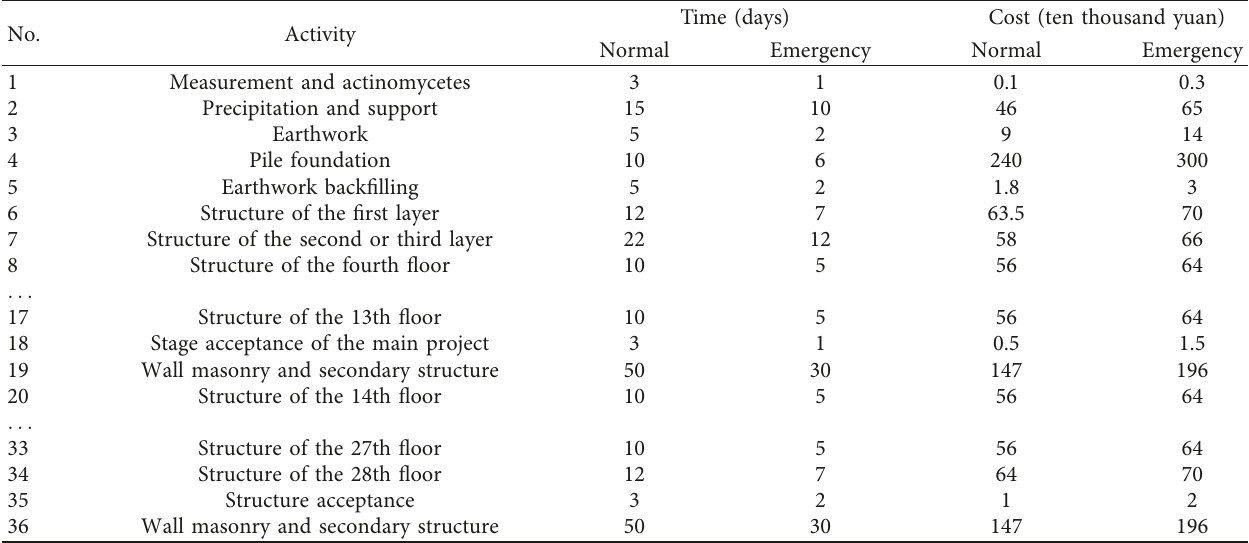
Table 3: Construction data.